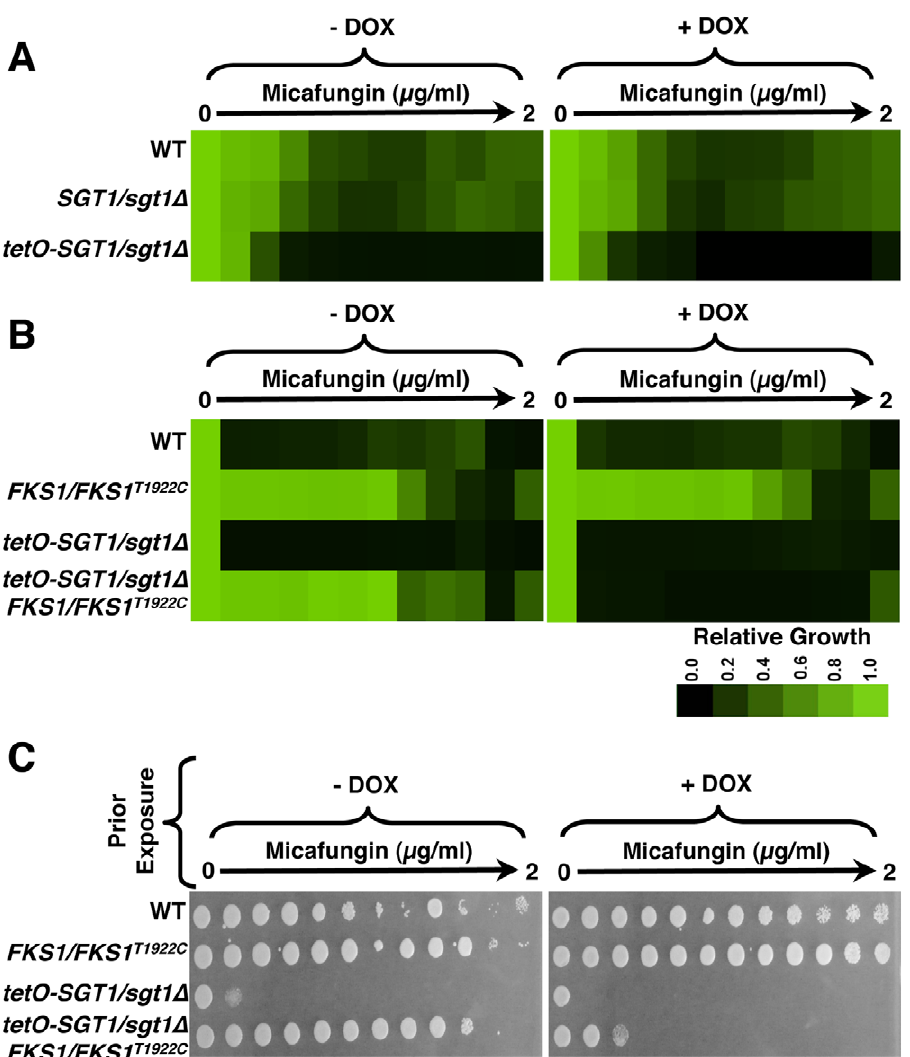
Figure 5. Reduction of Sgt1 levels enhances susceptibility to echinocandins and creates a fungicidal combination. (A) Reduced levels of Sgt1 enhances susceptibility to micafungin in minimum inhibitory concentration (MIC) assays. Assays were performed in YPD medium with a gradient of fluconazole from 0 to 2 m g/ml, in two-fold dilutions, with or without a fixed concentration of 20 m g/ml doxycycline (DOX), as indicated. Growth was measured after 72 hours at 30 u C. Data was analyzed as in Figure 4. (B) Reduced levels of Sgt1 renders echinocandin-resistant FKS1 mutants susceptible to micafungin in MIC assays. Assays were performed in YPD medium with a gradient of fluconazole from 0 to 8 m g/ml, in two- fold dilutions, with or without a fixed concentration of 20 m g/ml doxycycline, as indicated. Growth was measured after 72 hours at 30 u C. Data was analyzed as in Figure 4. (C) Reduction of Sgt1 levels creates a fungicidal combination with micafungin. MIC assays were performed in YPD medium with a gradient of fluconazole from 0 to 2 m g/ml, in two-fold dilutions, with or without a fixed concentration of 20 m g/ml doxycycline, as indicated. Assays were grown for 72 hours at 30 u C, and cells from the MIC assays were spotted onto YPD medium and incubated at 30 u C for 48 hours before plates were